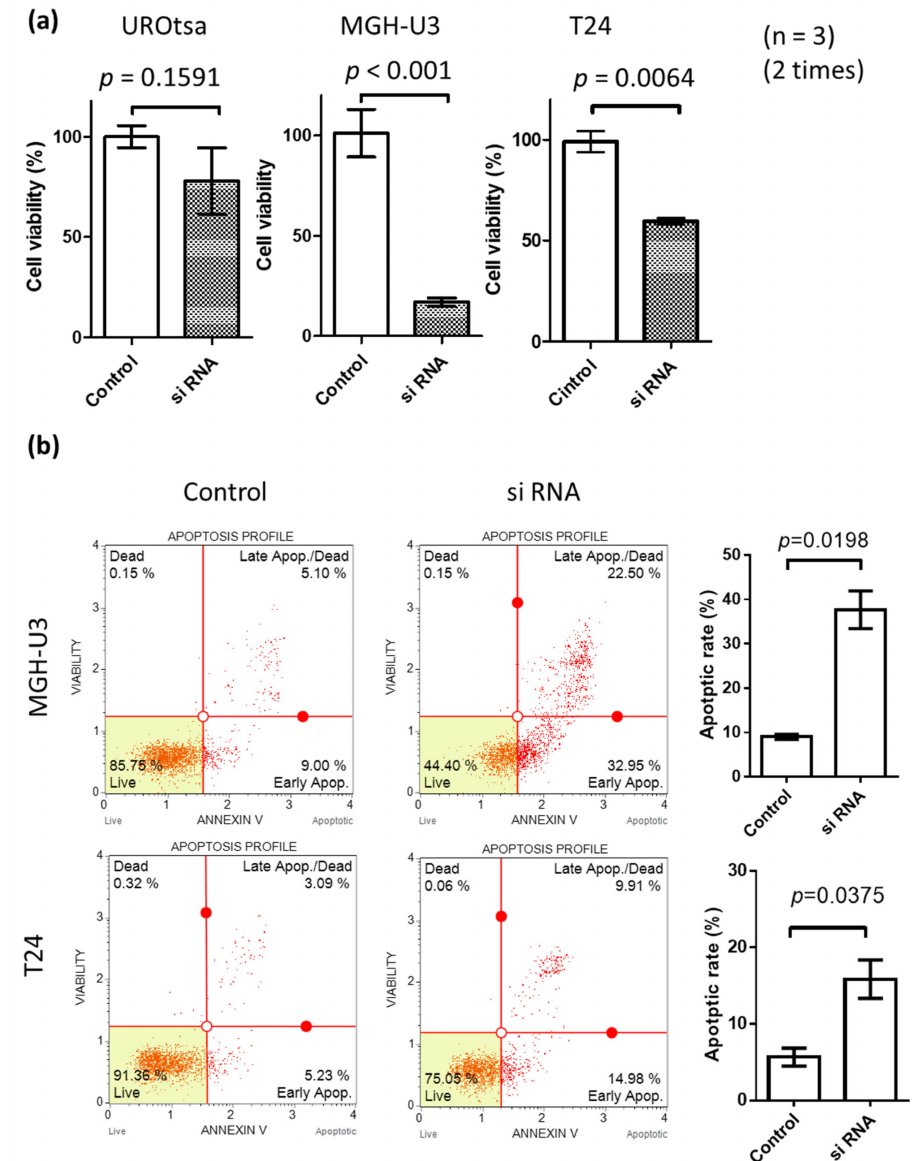
Figure 2. ( a ) Effect of heparanase knockdown on cell survival in urothelial carcinoma cells. Cell viability wasassessedbyanMTSassay72hfollowingtransfection; ( b )48hfollowingtransfection,cellsstainedwith Annexin V and propidium iodide were analyzed by flow cytometry (upper panels) and the percentages of apoptotic cells (AV[ + ] / PI[)]) calculated (lower panels). Inset photograph is an immunofluorescence microscopy image showing cells positive for FITC-conjugated Annexin V (AV). Each value is the mean ± standard error. C, control RNA (non-specific siRNA); Si RNA, heparanase